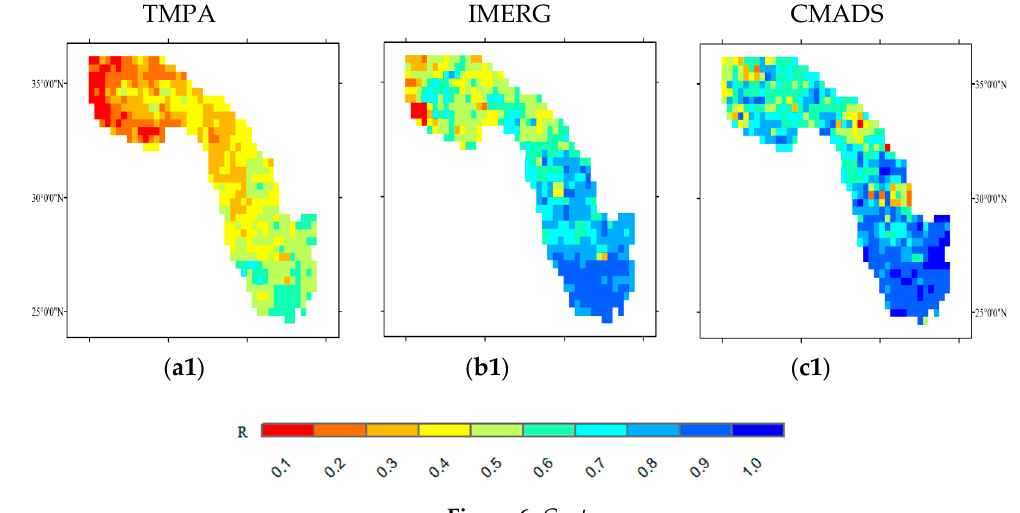
Figure 5. Accuracy assessment Taylor diagrams for satellite precipitation products: ( a , b ) full 2014– 2016 cycle; ( c , d ) first dry season; ( e , f ) first rainy season; ( g , h ) second dry season; ( i , j ) second rainy